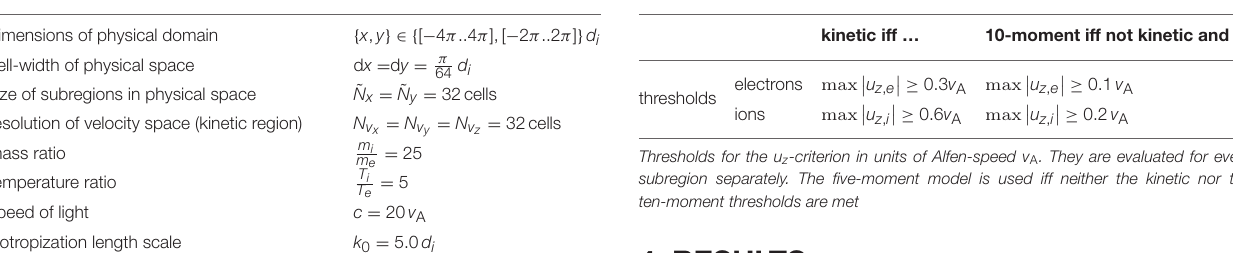
TABLE 2 | Numerical setup of GEM. TABLE 3 | Numerical setup of